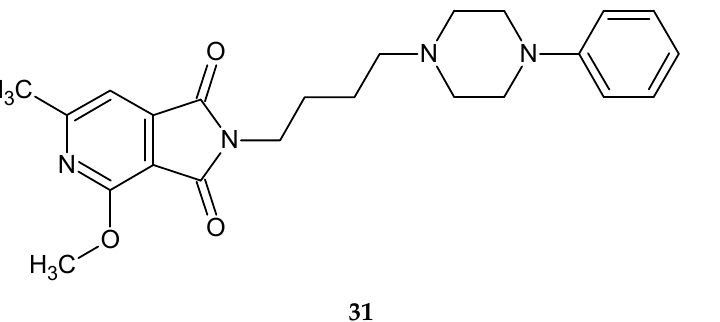
Figure 25. 2 ‐ [(4 ‐ phenyl ‐ 1 ‐ piperazinyl)butyl] ‐ 4 ‐ methoxy ‐ 6 ‐ methyl ‐ 1 H ‐ pyrrolo[3,4 ‐ c ]pyridine ‐ 1,3(2 H ) ‐ dione 31.